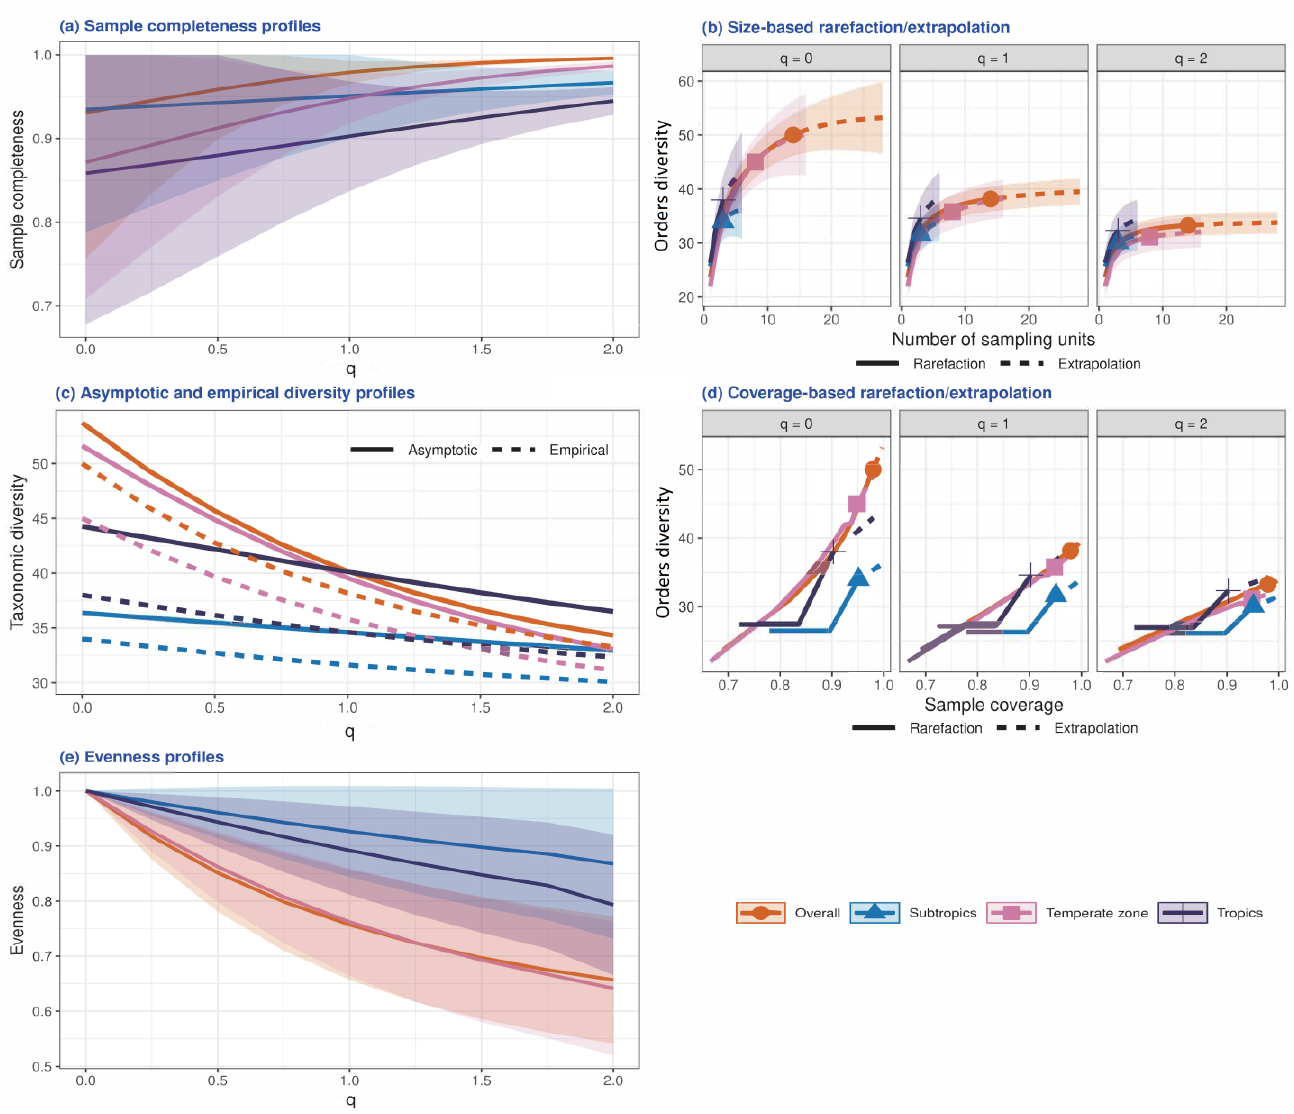
Figure 2. ( a ) The plots of the estimated sample completeness curves as a function of sequence q between 0 and 2 for soil fauna in East Asia. ( b ) Sample-size-based rarefaction (solid lines) and extrapolation curves (dashed lines). ( c ) The asymptotic estimates of diversity profiles (solid lines) and empirical diversity profiles (dotted lines); numerical values refer to the estimated asymptotic diversities. ( d ) Coverage-based rarefaction (solid lines) and extrapolation (dashed lines) curves up to the corresponding coverage value for a doubling of each reference sample size. ( e ) Evenness profile as a function of sequence q for 0 < q ≤ 2, based on the normalized slope of Hill numbers. Solid dots and triangles denote observed data points. All the shaded areas in ( a – d ) denote 95% confidence bands obtained from a bootstrap method with 100 replications. The numerical values for the three special cases of q = 0, 1 and 2 are shown in Table S2 [62].